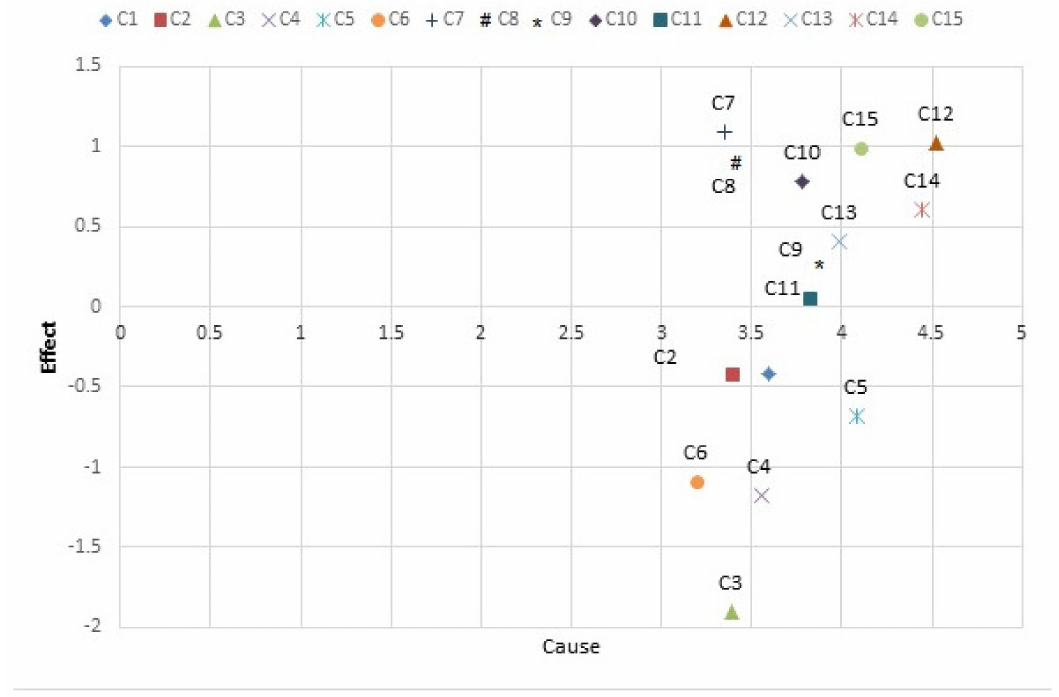
Figure 3. The relationship between cause and